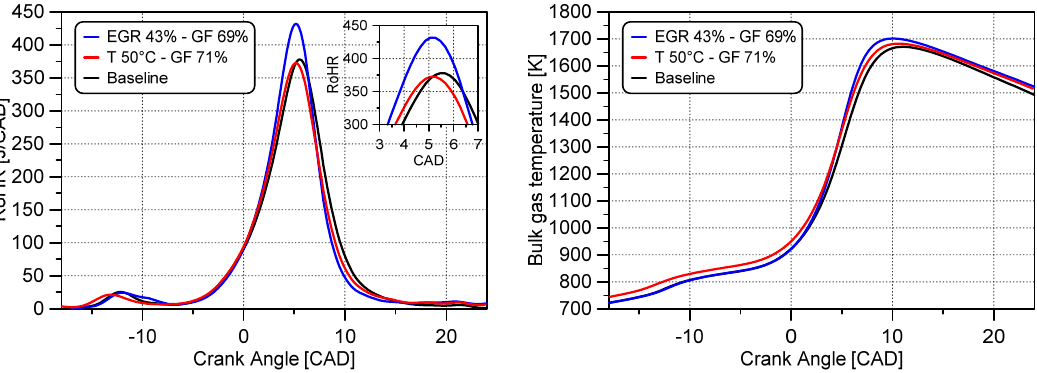
Figure 5. RoHR traces and bulk gas temperature for the best tests of both strategies and that for the baseline condition at 7.5 bar IMEP and 1200